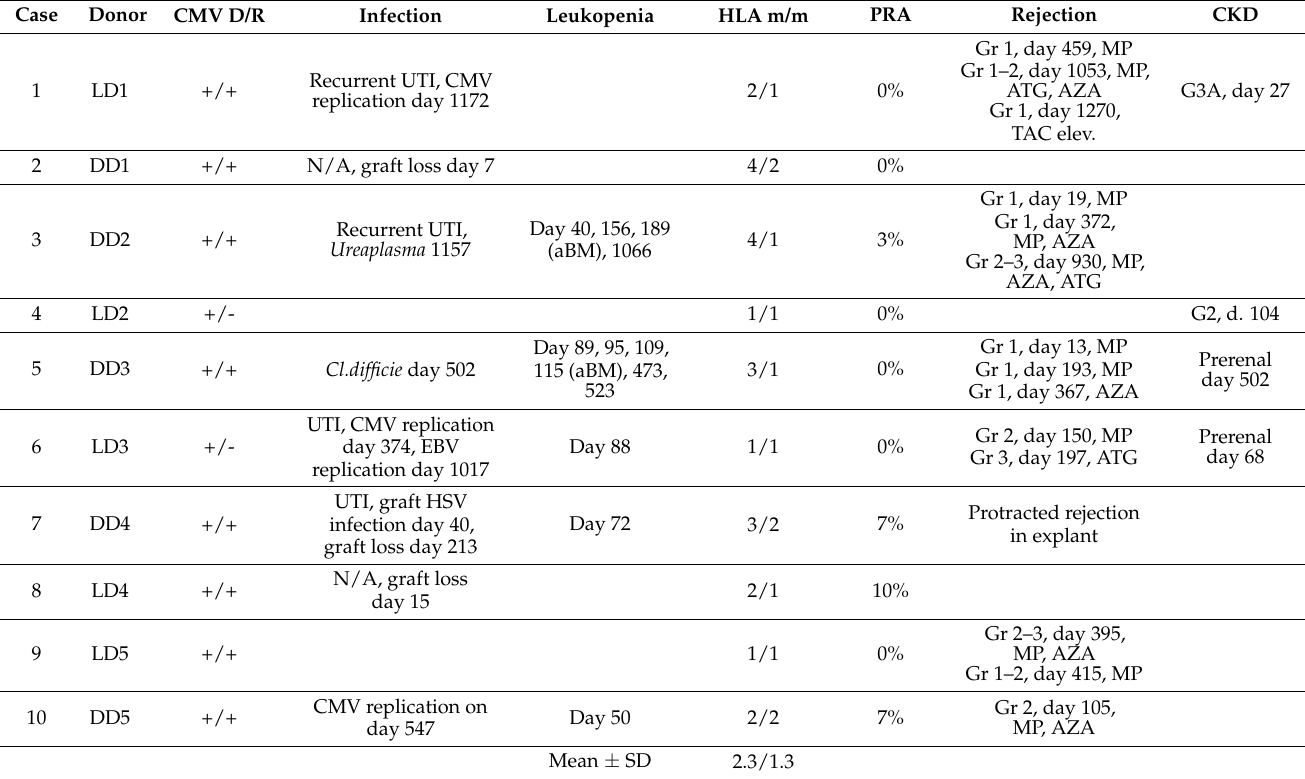
Table 6. Complications of 10 consecutive uterus transplant recipients regarding infection, leukopenia, rejection and renal